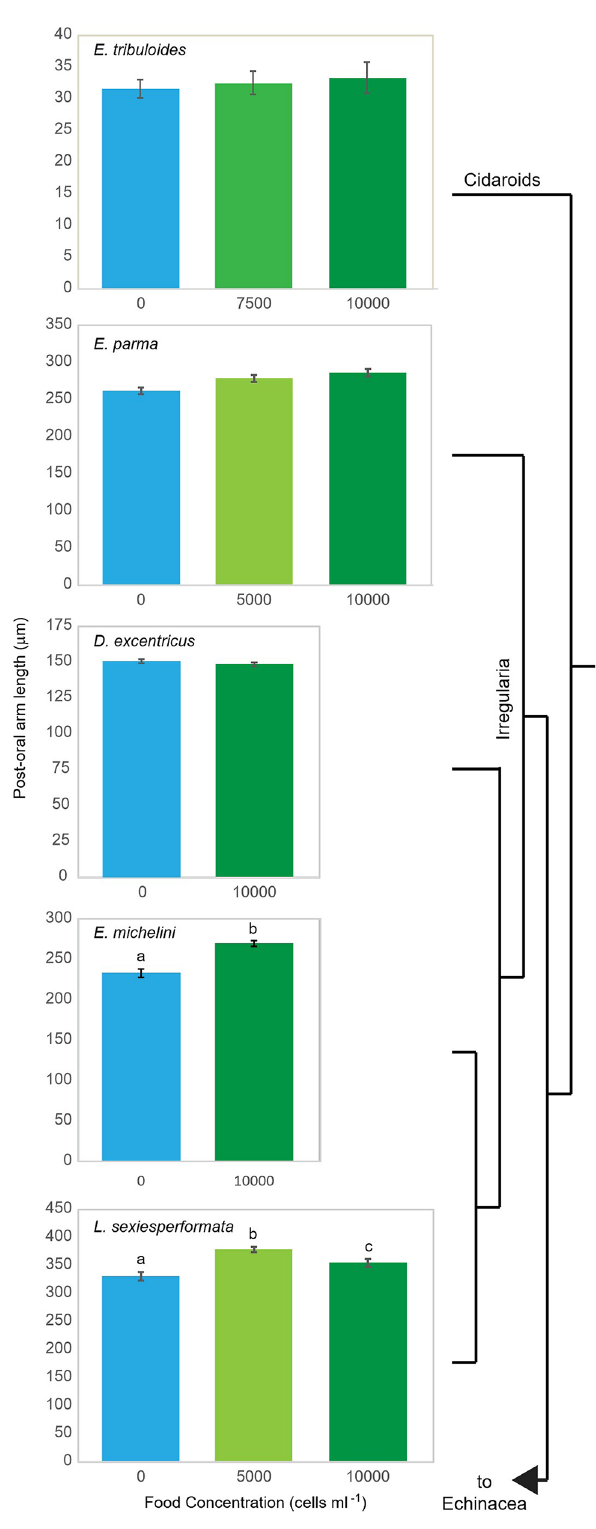
Figure 1. Canonical pre-feeding plasticity is absent in the basal Cidaroids and irregular urchins. Change in post-oral arm length at initiation of feeding averaged across families with food concentration in the Cidaroids and Irregularia. Phylogenetic tree is not scaled to divergence. Error bars, ± standard error of the mean. Letters denote a significant difference between food treatments at p < 0.05 (Table